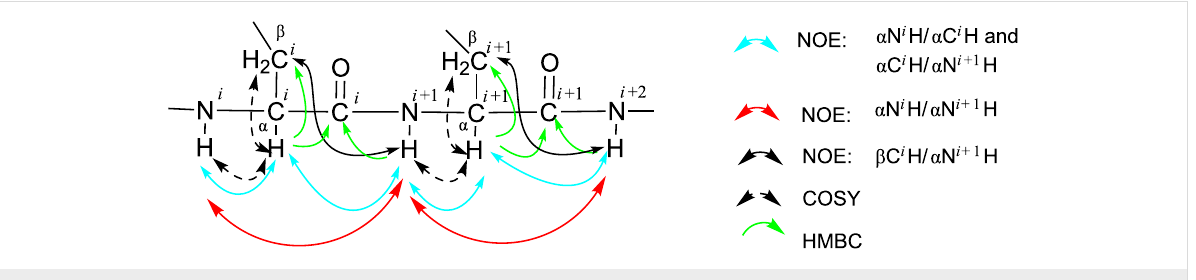
Figure 4: Key NMR observations used to construct the backbone sequence.